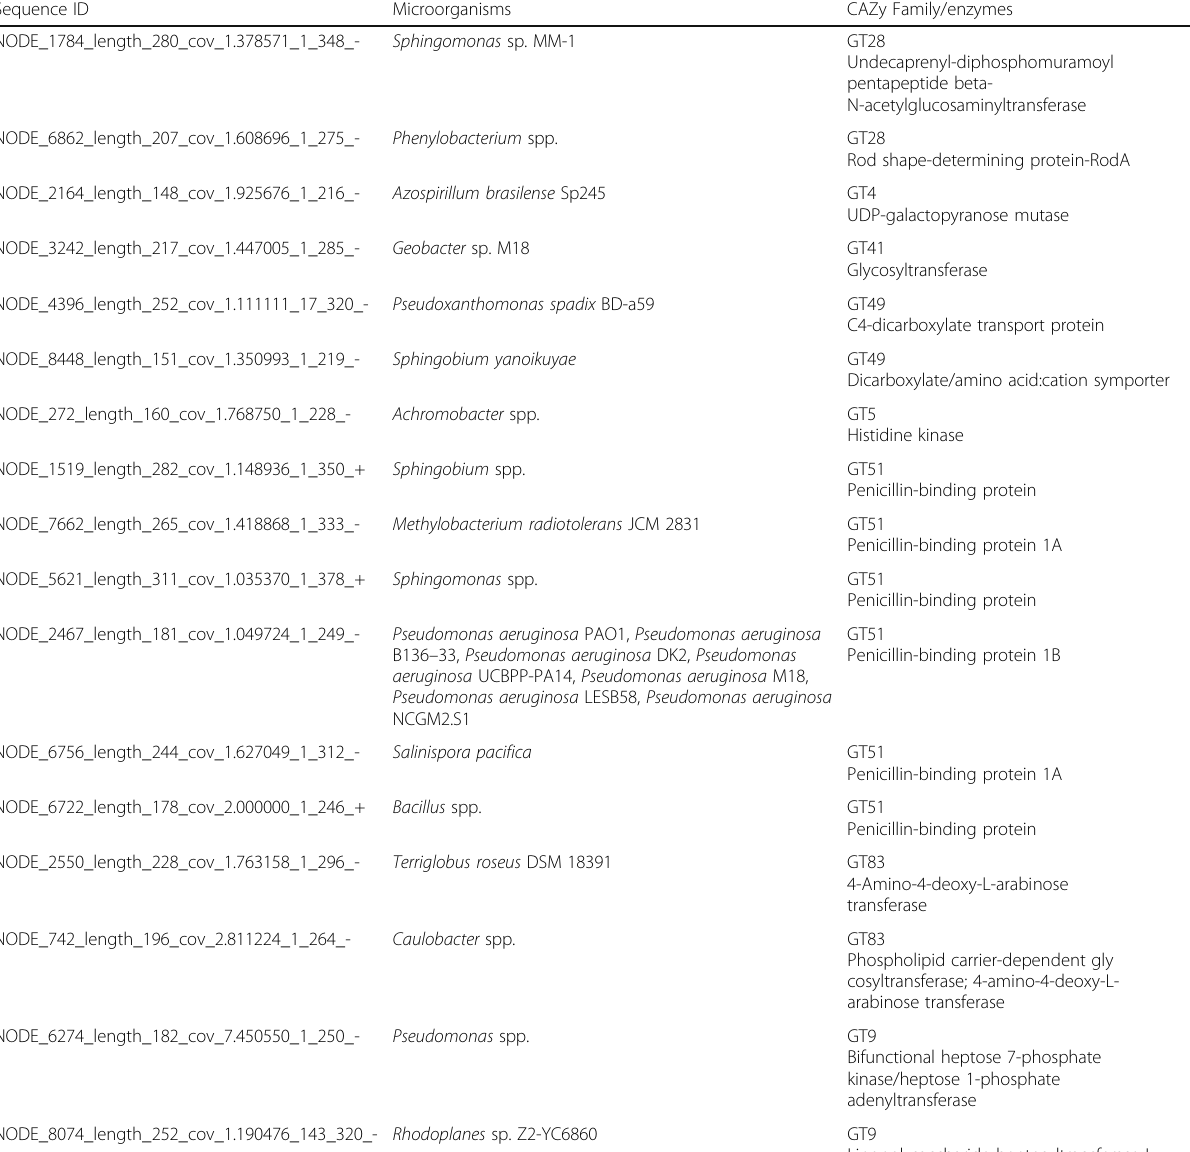
Table 2 List of AB1 microcosm sequences annotated for carbohydrate-active enzymes (CAZy) and their taxonomic affiliations